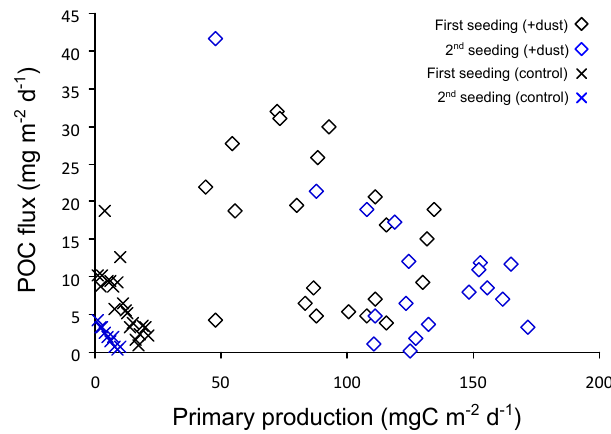
Fig. 5. POC flux for all of the mesocosms versus integrated primary production (PP). No significant correlation existed between PP and the POC flux in the +dust mesocosms (Fisher test, p values >